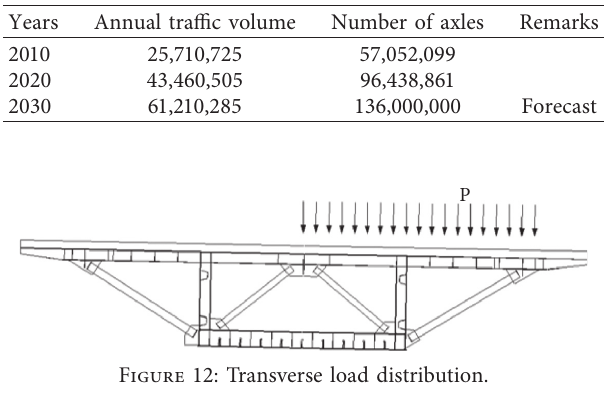
Figure 11: Total axle load spectrum. Table 4: Annual traffic volume and axle number for Dazhenggang Bridge.